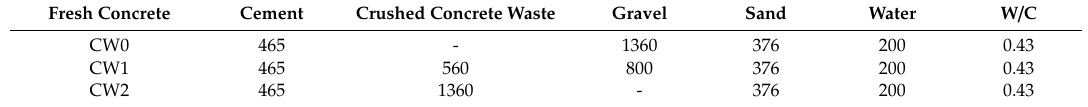
Table 2. Concrete compositions with various amounts of crushed concrete waste for 1 m 3 of